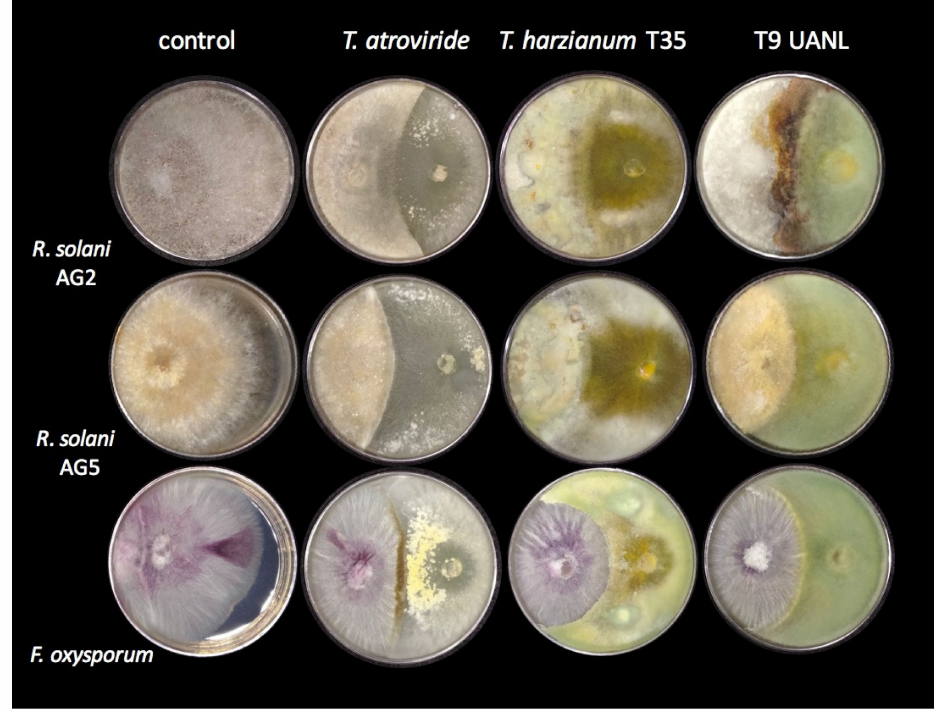
Figure 4. Trichoderma strains during mycoparasitic activity. Confrontations of the environmental strain, T. harzianum T35 and T. atroviride against three principal phytopathogens. The test was developed in triplicate in PDA for 72 h at 28 ◦